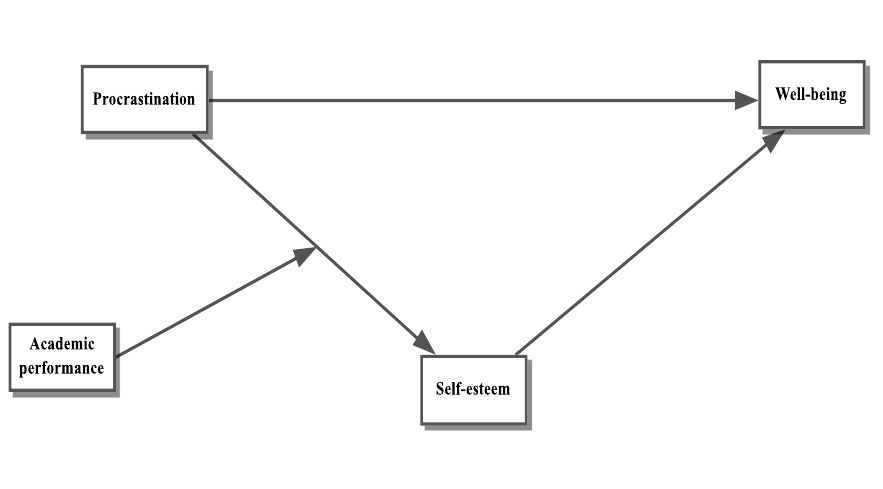
Figure 1. Conceptual model of effect of procrastination on